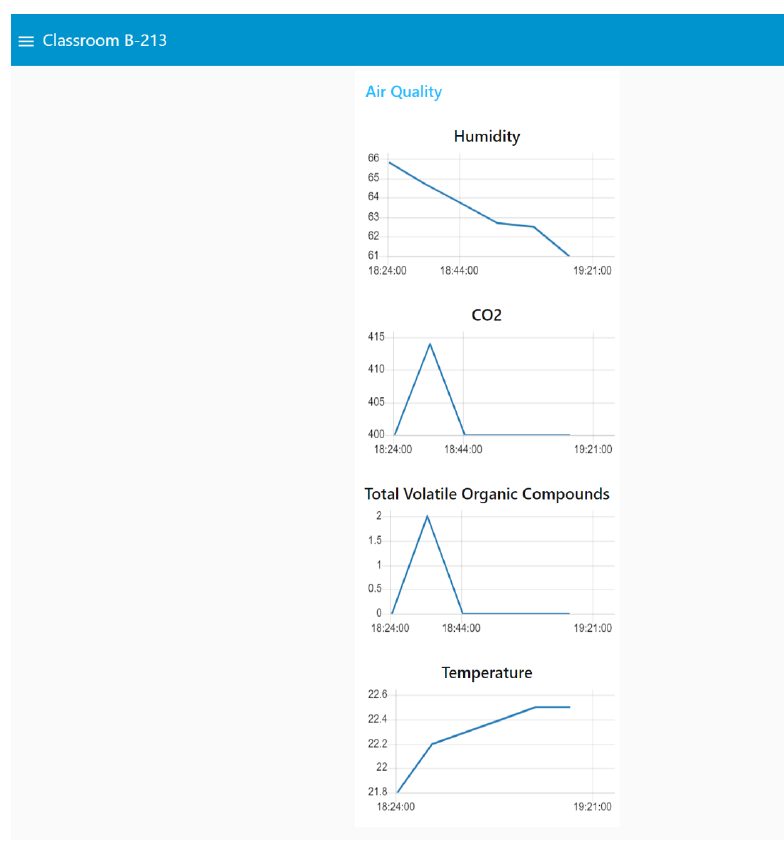
Figure 13. Real-time monitoring data from a